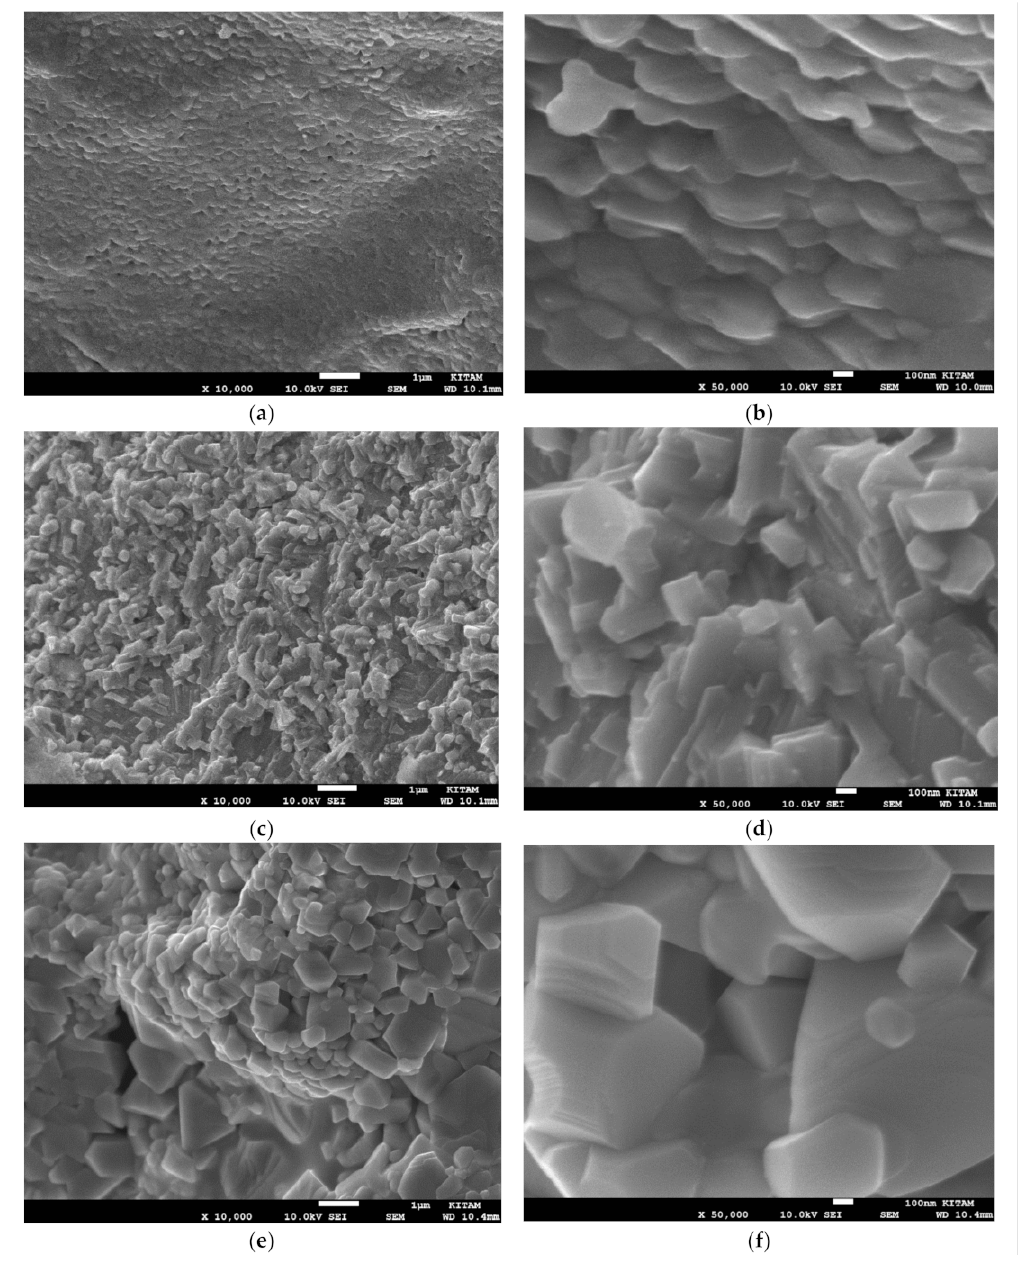
Figure 36. SEM evaluation surface structure of the Mn / Cu / Si = 1 / 0.5 / 1 catalyst as a function of composition after 60 s extra irradiation. Images at two magnifications: 10k; (scale bar = 1 µ m); 50k; (scale bar = 100 nm). ( a , b ) Surface structure at mean Mn concentration with [Mn] = 0.250, [Cu] = 0.114, [Si] = 0.074, [O] = 0.562; ( c , d ) Mn-rich pore surface with [Mn] = 0.806, [Cu] = 0.040, [Si] = 0.052, [O] = 0.102; ( e , f ) Cu-rich pore surface with [Mn] = 0.167, [Cu] = 0.302,[Si] = 0.044, [O] =